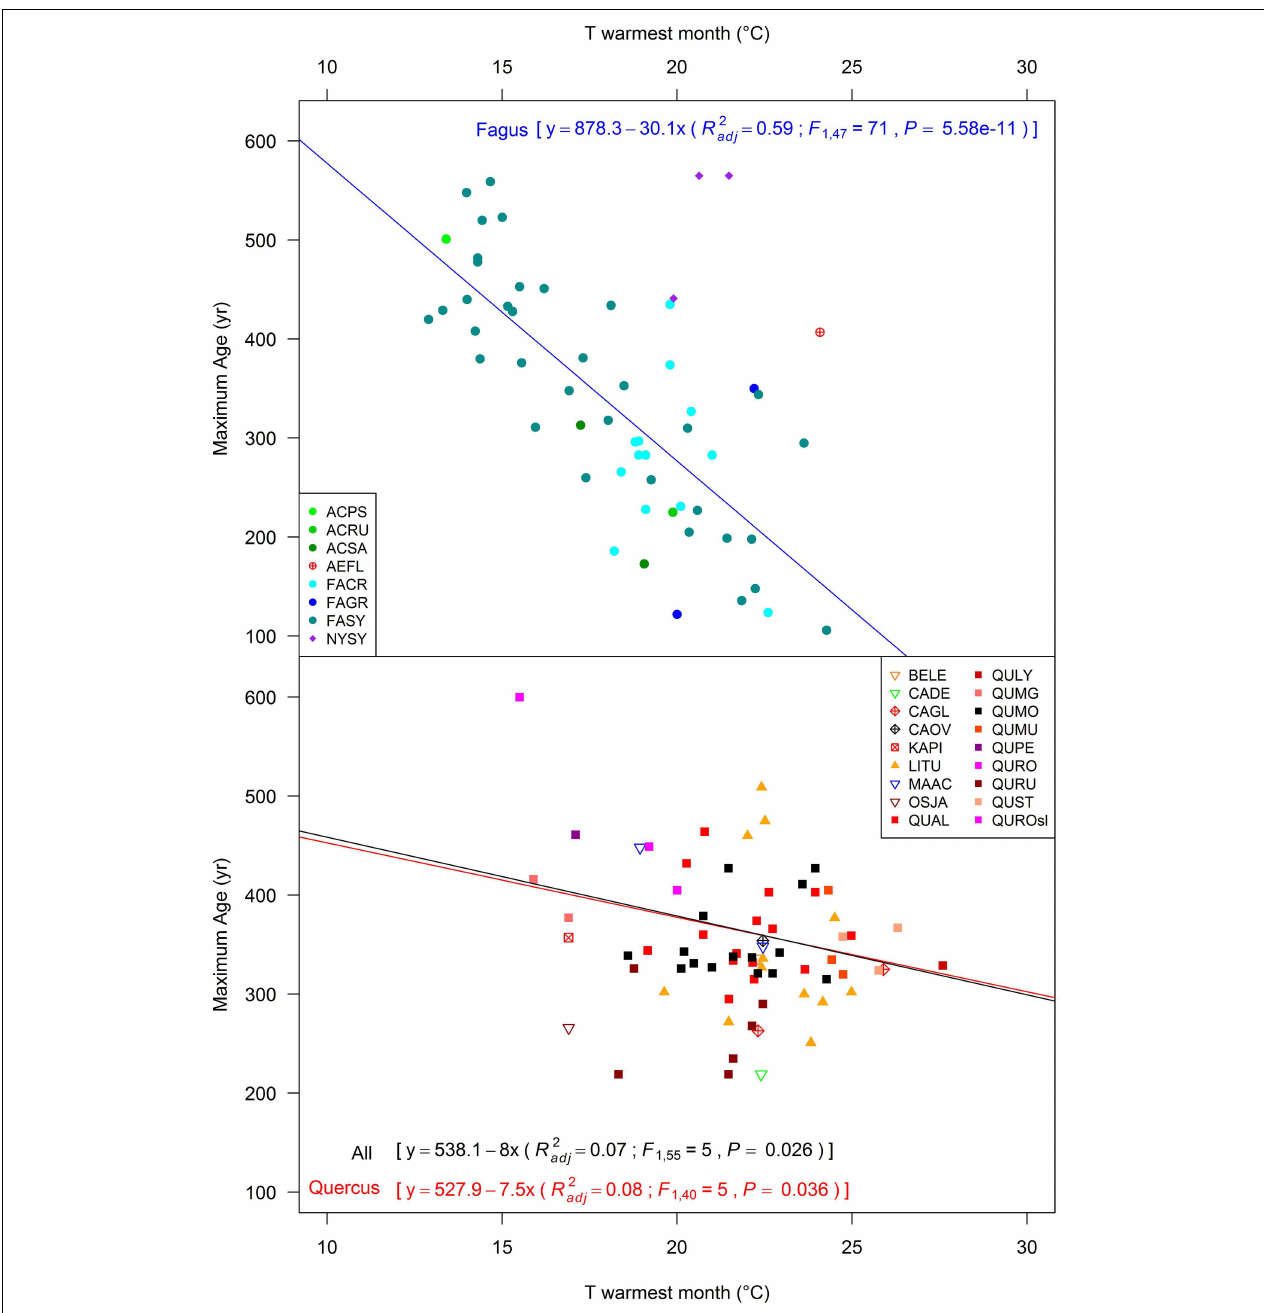
FIGURE 4 | Relationships between the age of the oldest deciduous tree within each temperate old-growth forest and its mean ring-width. Values are represented using log-transformed scales, regression lines were developed for all sites together and